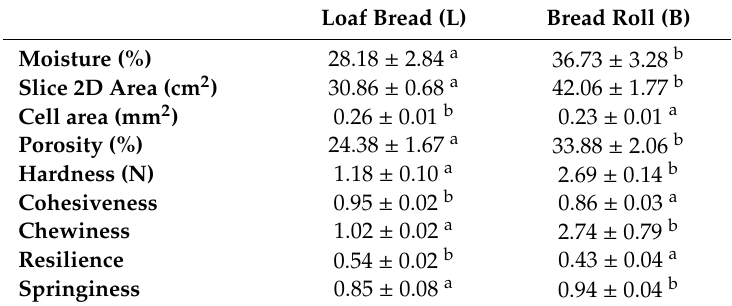
Table 1. Moisture, morphological and texture parameters of the wheat bread crumbs.